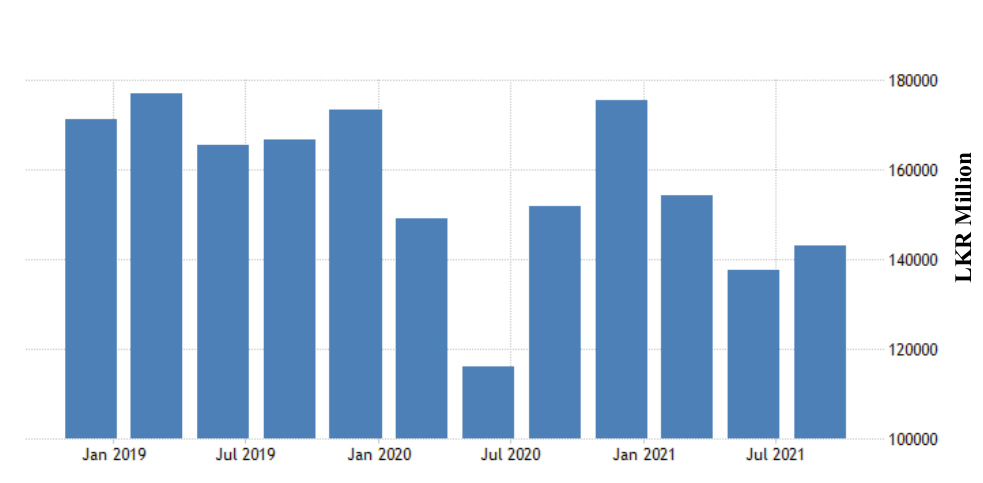
Fig. 2. GDP from construction in Sri Lanka, LKR million (Trading Economics, 2022).